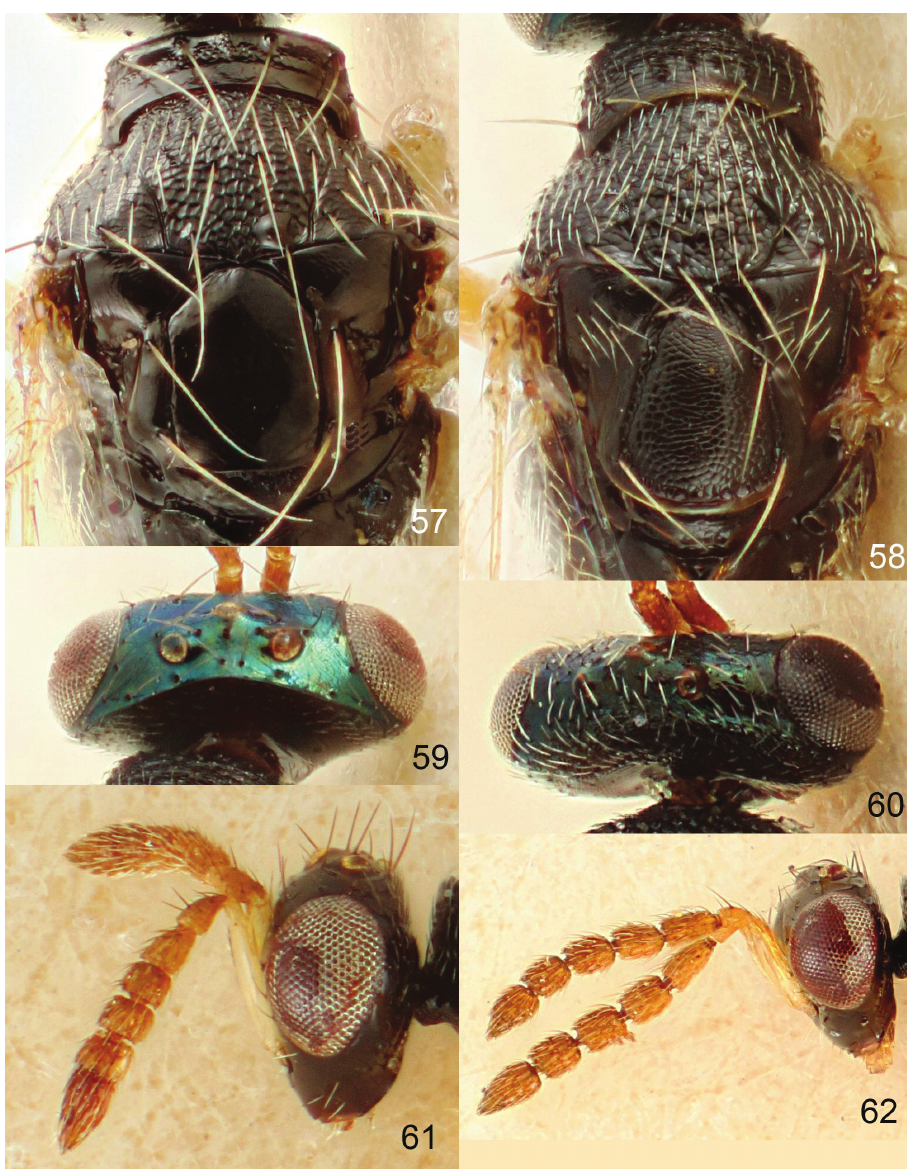
Figures 57–62. Platyplectrus spp., females: 57–58 mesoscutum and scutellum, dorsal 57 P. laeviscuta (Thomson) 58 P. pannonica Erdös 59–60 vertex 59 P. pannonica 60 P. chlorocephala (Nees) 61–62 head including antenna, lateral 61 P. bouceki (Erdös) 62 P. laeviscuta